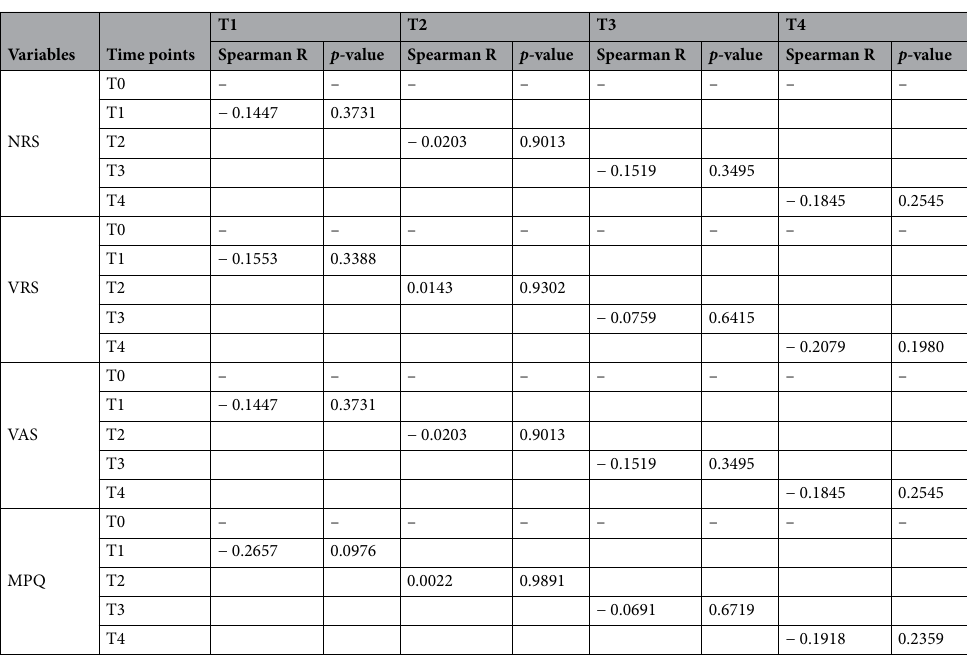
Table 3. Correlation between Calcitonin Gene Related Peptide (CGRP) with NRS, VRS, VAS and MPQ scores by Spearman’s rank